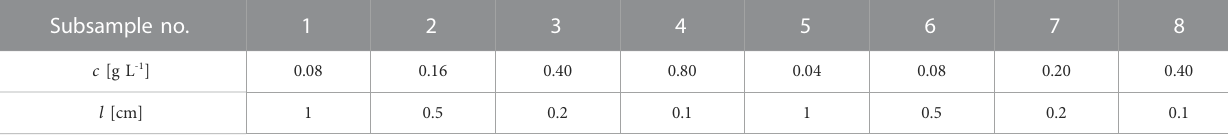
TABLE 2 The setups of concentration ( c ) and path length ( l ) for the suspensions of Phaeodactylum tricornutum and Chlorella vulgaris . The pigment solutions have almost the same setups, but with smaller proportions of the concentrations: chlorophyll a at 10% and fucoxanthin at 2.5% of the concentrations shown in the table. Subsample